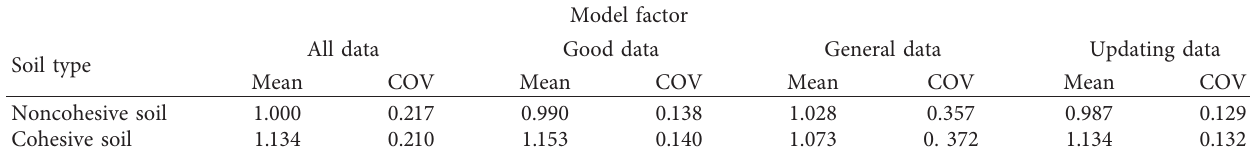
Table 5: The updating model factor for pile